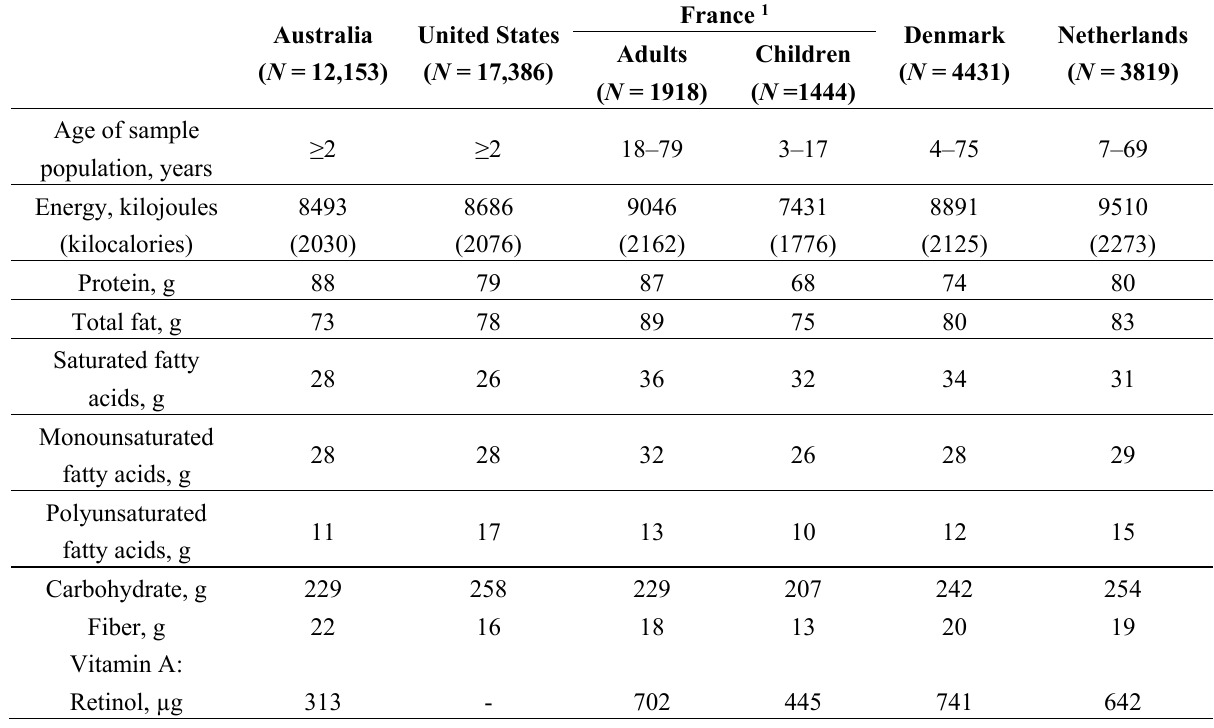
Table 3. Mean intake of energy and nutrients in five developed